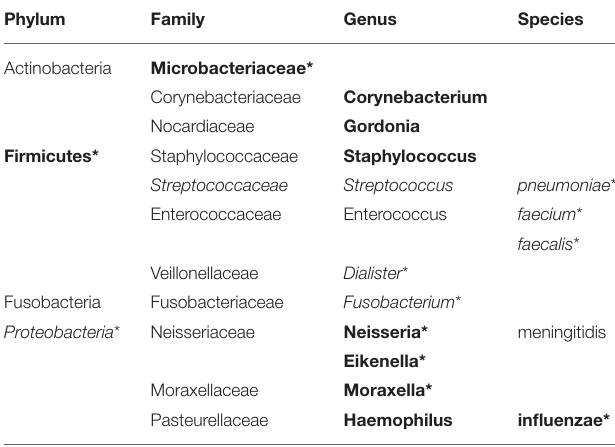
TABLE 2 | Bacterial Glossary of recognized upper airway